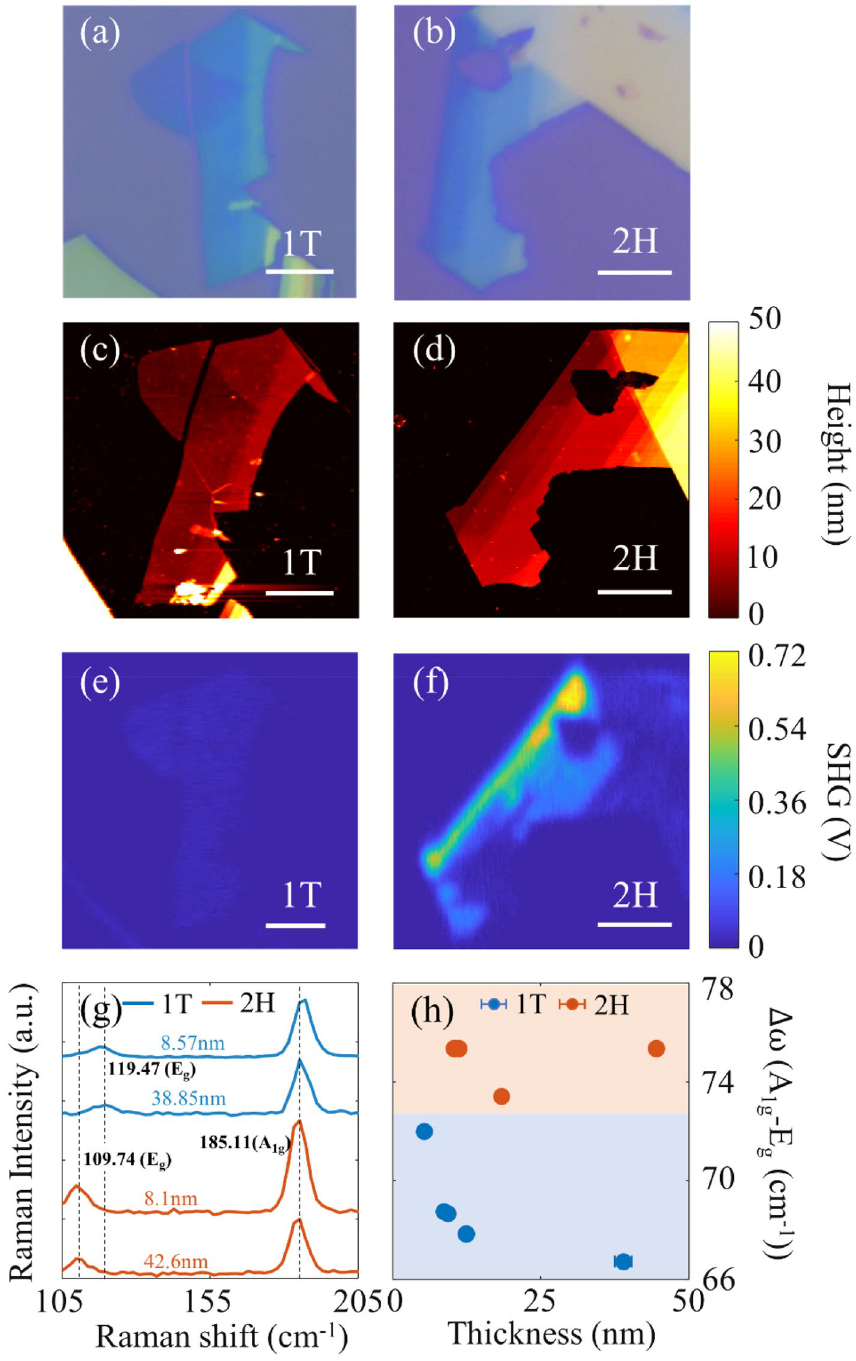
Figure 1. Optical images of: ( a ) 1T, ( b ) 2H polytype of SnSe 2 . AFM images of: ( c ) 1T, ( d ) 2H polytypes of SnSe 2 . SHG images of: ( e ) 1T, ( f ) 2H polytypes of SnSe 2 . Scale bar for all images is 5 μm ( g ) Raman spectra of 1T (blue solid curves) and 2H (orange solid curves) sample, the dashed black line indicates the Raman peak positions of the E g and A 1g Raman modes. ( h ) Thickness dependent A 1g –E g Raman peak separation for SnSe 2 , 1T (blue solid circles) and 2H (orange solid circles). (Created in MATLAB v9.6, R2019a, https:// in. mathw orks.